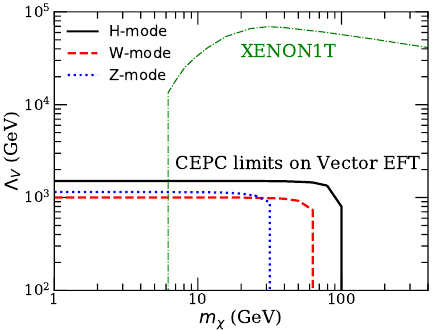
Figure 17 . Comparison between CEPC sensitivity and SI limits from Xenon1T [53] under the assumption that the EFT couplings are universal for SM